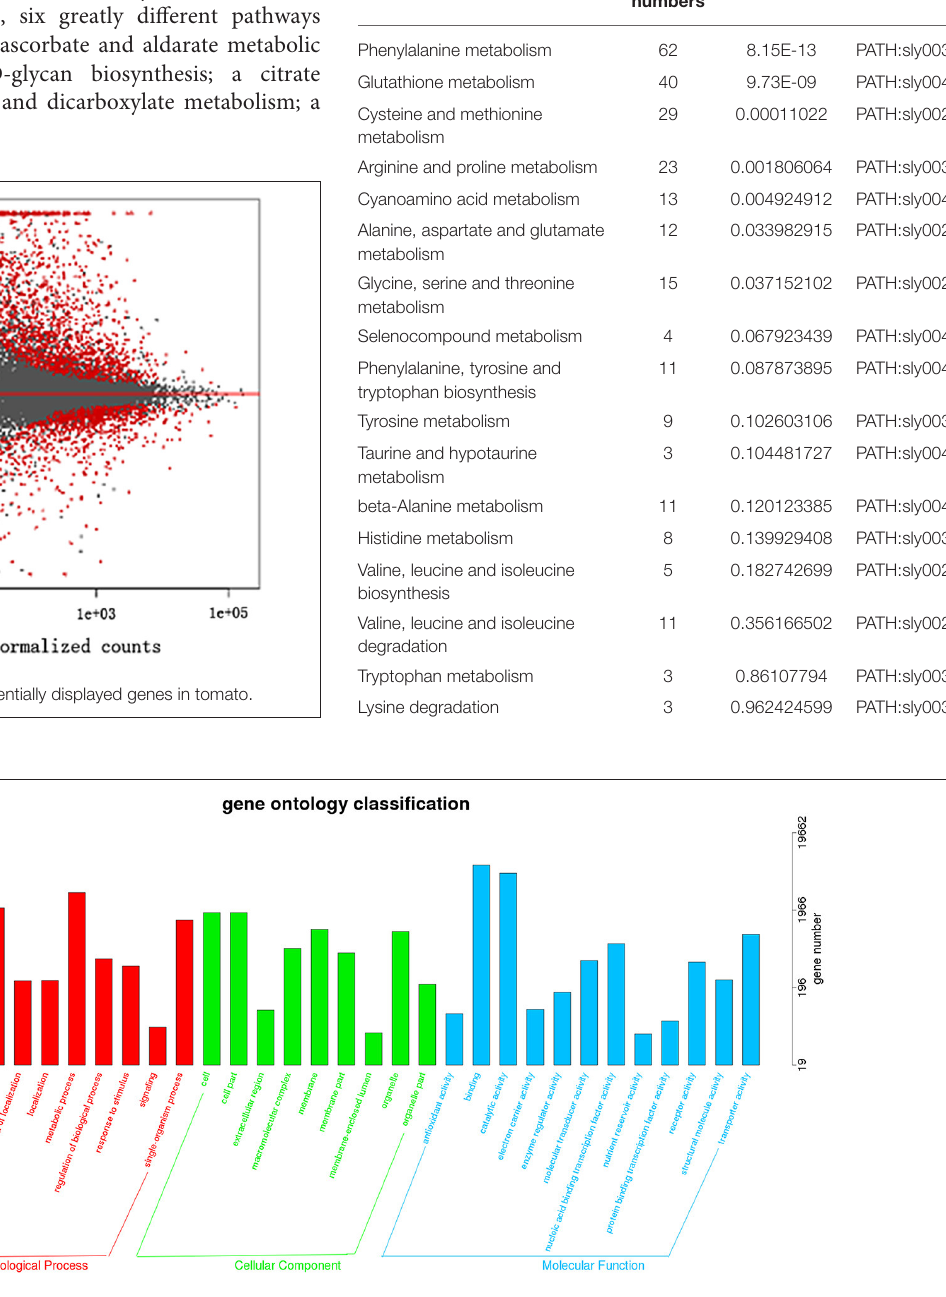
FIGURE 2 | Histogram representation of Gene Ontology